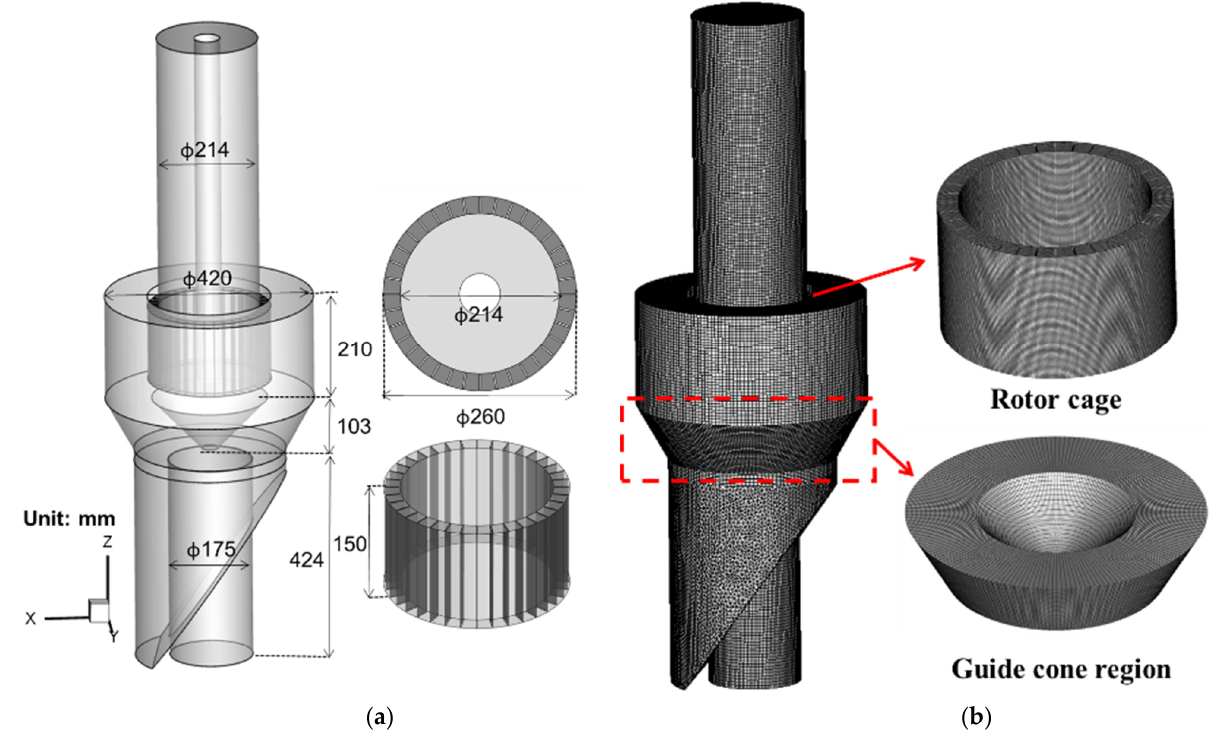
Figure 2. Dimensions ( a ) and CFD grid ( b ) of the dynamic air classifier.